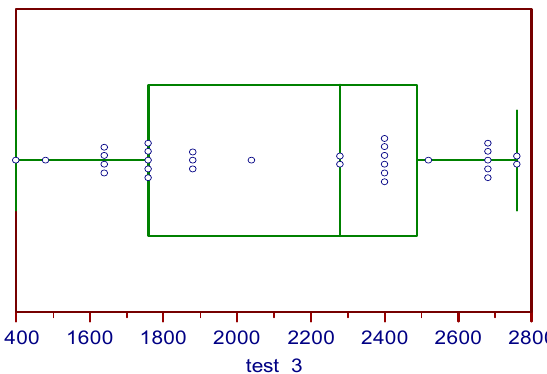
Figure 2. Outliers detection. Box-and-whisker plots for Tukey HSD ( post-hoc ) test: anyone outliers both in the 2nd and 3rd session of YYiR1.